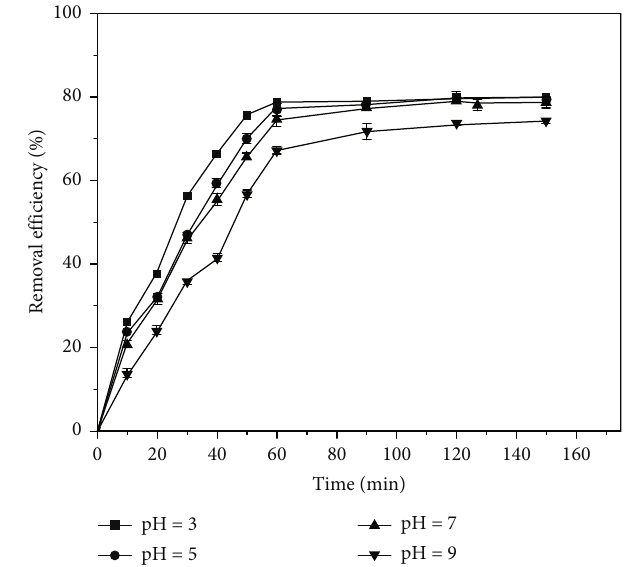
Figure 4: NO -N removal rates for di ff erent materials (ATP, Fe, 3 nZVI, and ATP-nZVI). ATP: attapulgite; ATP-nZVI: nano-zero- valent iron-coated attapulgite; nZVI: nano-zero-valent iron (initial -N concentration = 30 mg/L, adsorbent = 1 : 5 g/L, pH = 7 , NO 3 reaction temperature = 25 ° C, and contacttime = 150 min).